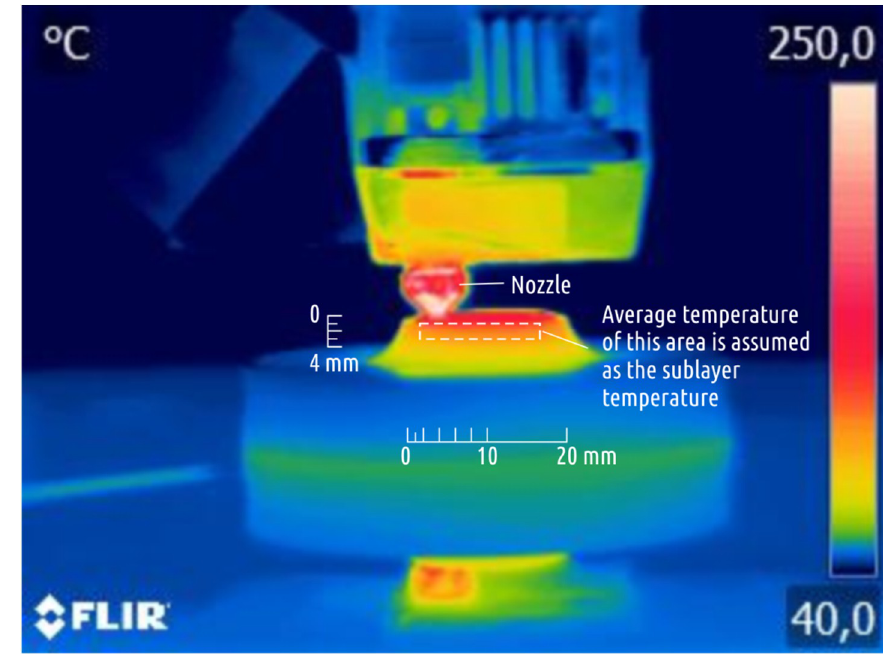
Figure 5. Sublayer temperature evaluation.